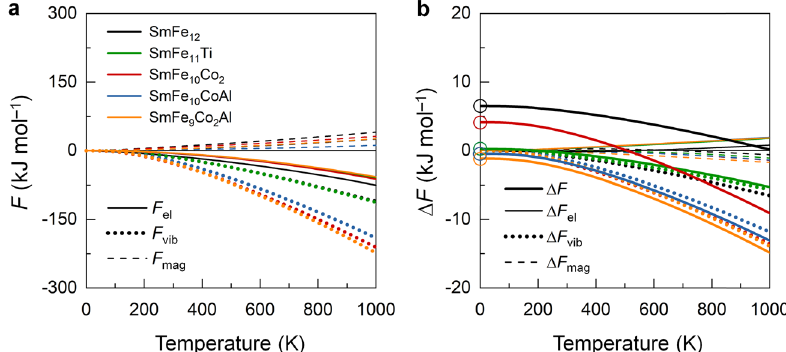
Fig. 6 Thermodynamic phase stability. Temperature-dependent a free energy contributions of the electronic F el ( T , V ), vibrational F vib ( T , V ), and magnon F mag ( T , V ), and b free energy change Δ F ( T , V ) of SmFe 12 , SmFe 11 Ti, SmFe 10 Co 2 , SmFe 10 CoAl, and SmFe 9 Co 2 Al. In b the contributions of the electronic Δ F el ( T , V ), vibrational Δ F vib ( T , V ), and magnon Δ F mag ( T , V ) to Δ F ( T , V ) are also presented for each compound. Open symbols at 0 K represent the formation enthalpy H bin f